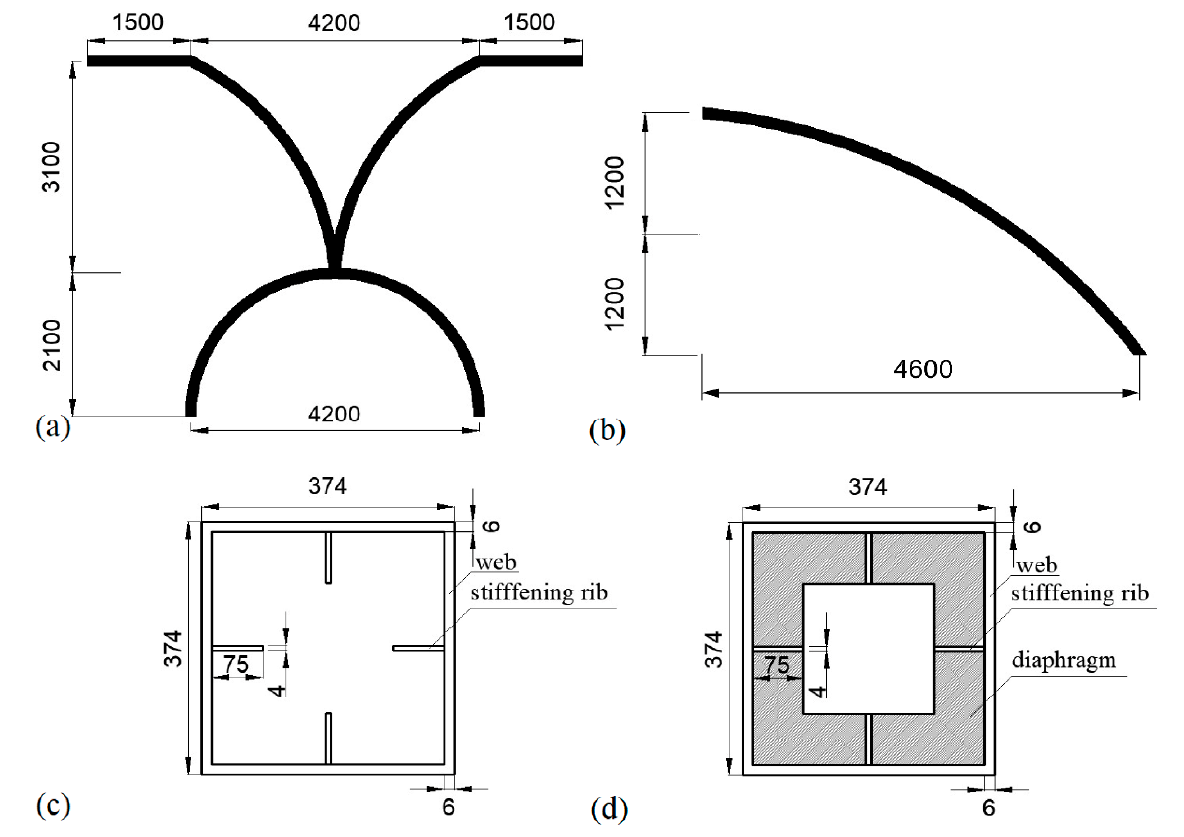
Figure 4. Specific geometrical details of the FEA model—( a ) whole model, ( b ) lateral view of the model (relative position in the dome), ( c ) cross-section with stiffening ribs, ( d ) cross section with stiffening ribs and diaphragms (units in mm). Table 2. Load magnitude associated with the loading point shown in Figure 3b.